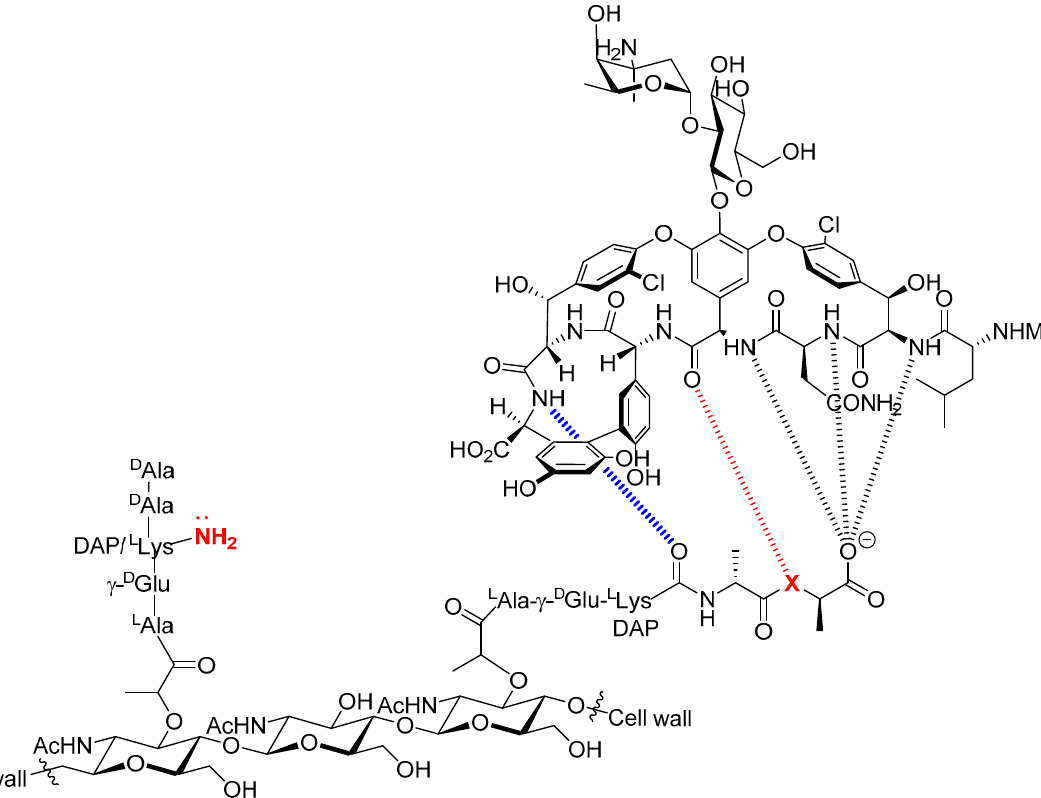
Figure 1. Chemical structure of vancomycin and description of the acquired resistance to vancomycin. The antibacterial activity of vancomycin stems from its high binding affinity(4.4 × 10 5 M − 1 ) for the terminal D-Ala-D-Ala sequence of the precursor peptidoglycan pentapeptide [29]. This binding creates a steric blockade which prevents the enzyme-mediated transpeptidation of the free amine of D-Lys or diamino pimelic acid (DAP) on the second last D-Ala residue from occurring. This in turn induces inhibition of bacterial cell wall biosynthesis. The origin of VanA and VanB bacterial resistance stems from a change in amino acid composition from D-Ala-D-Ala (X = NH) to D-Ala-D- Lac (X = O) [14]. The presence of an ester instead of an amide moiety suppresses a hydrogen bond and introduces a repulsive interaction between oxygen-centered lone pairs. This in turn is responsible for the 1000-fold reduction of binding affinity of vancomycin for the peptidoglycan